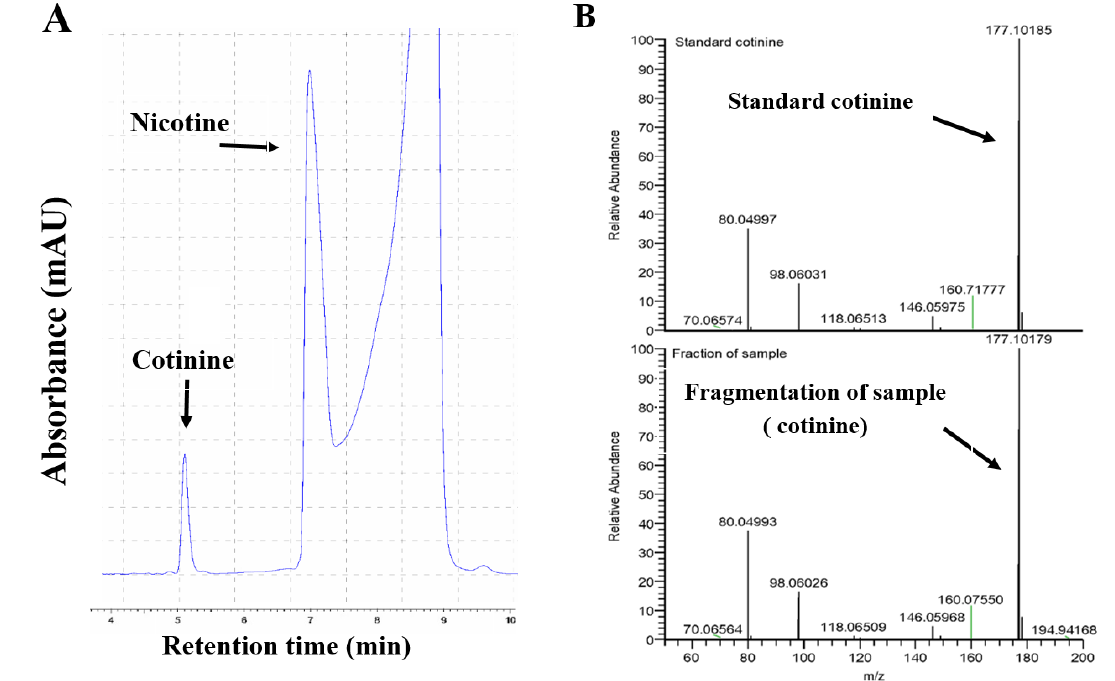
Figure 6. Cotinine formation rate of in vitro nicotine metabolism. The nicotine metabolism was measured by HPLC-L as described in the Section 4. ( A ) presents the HPLC chromatogram separation of the cotinine, which was produced in liver microsomes of a PreSE male mouse ( B ) presents the cotinine analysis by LCMS. Cotinine, corresponding with m/z 177 was detected both in a blank sample containing standard cotinine and in the microsome sample.